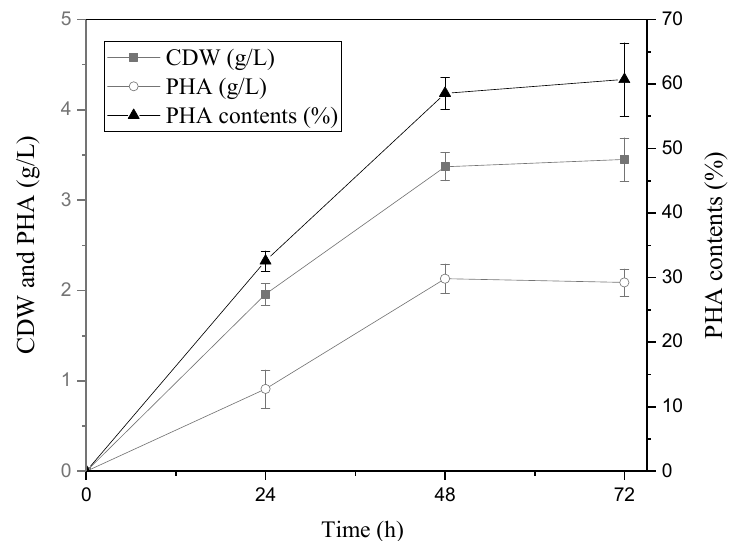
Figure 5. PHA production by P. resinovorans in optimized condition. Batch culture was performed in 7 L scale jar fermenter (3 L as working volume) with optimized culture medium.